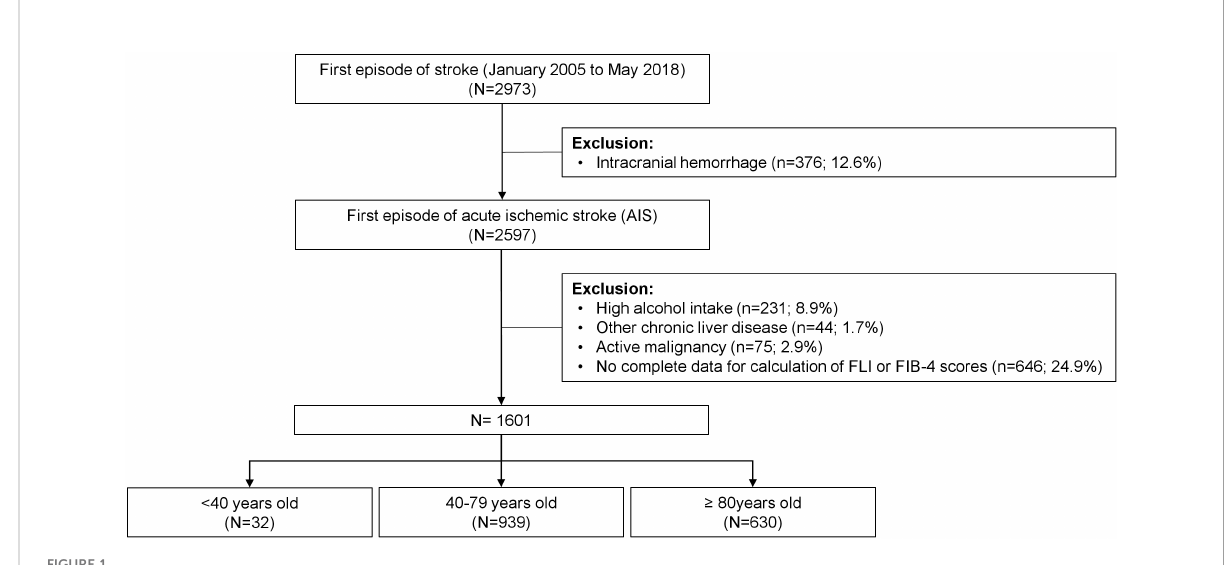
FIGURE 1 Flow-chart of patients included in the